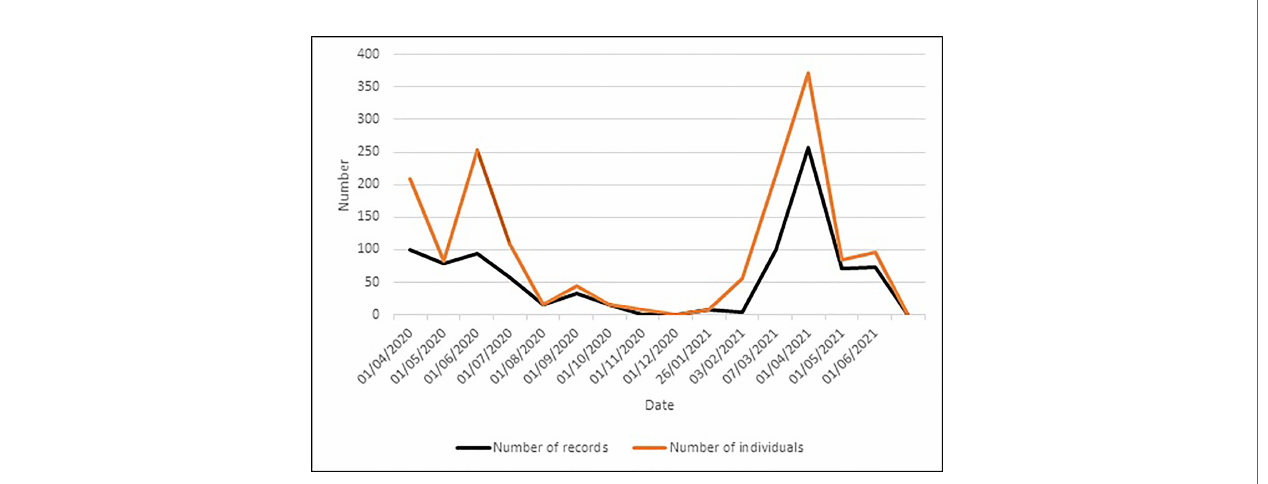
FIGURE 3 | Number of records (n = 924) and number of individual ladybirds (n = 1591) recorded between April 2020 and June 2021 during our citizen science campaign in